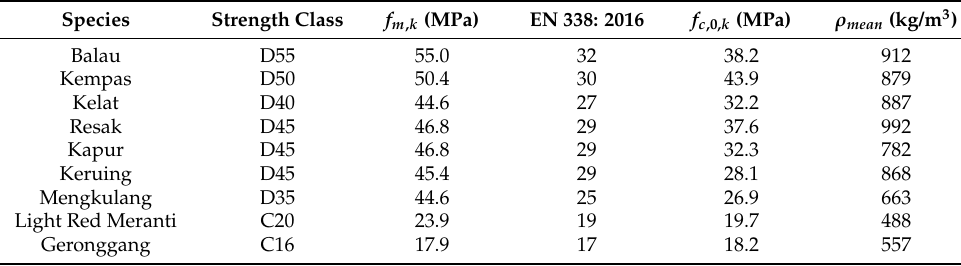
Table 5. Experimental characteristic values of compressive and bending strength with the values in EN 338 [11] for the respective strength